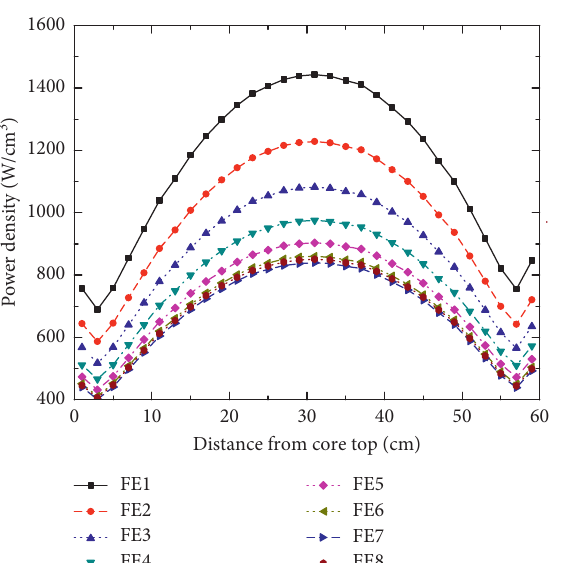
Figure 7: Axial power profile of the hottest channel in the hottest assembly located at cell 8–4. The fuel elements are numbered from outer to inner elements in the assembly. Table 3: Control rod worths in pcm unit of the MPRR